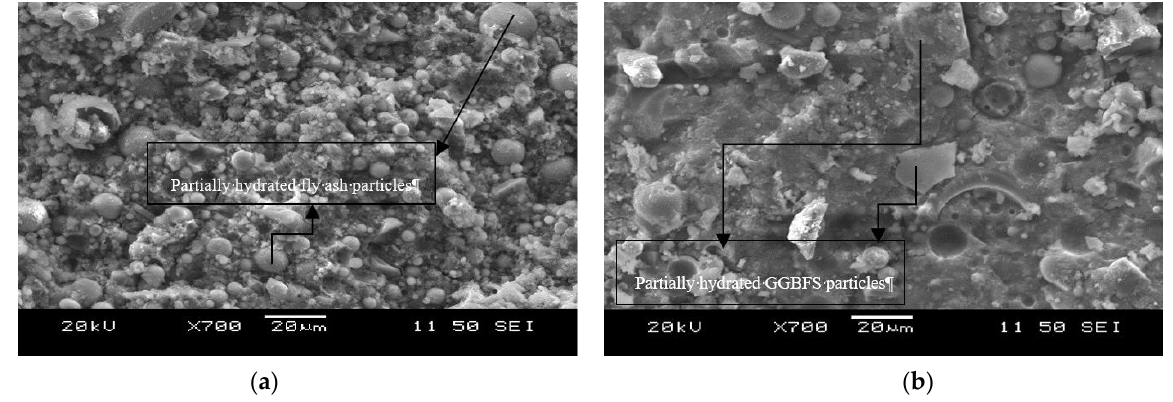
Figure 10. Morphology of binders using SEM ( a ) CFS-4-1; ( b ) CFS-5-2.